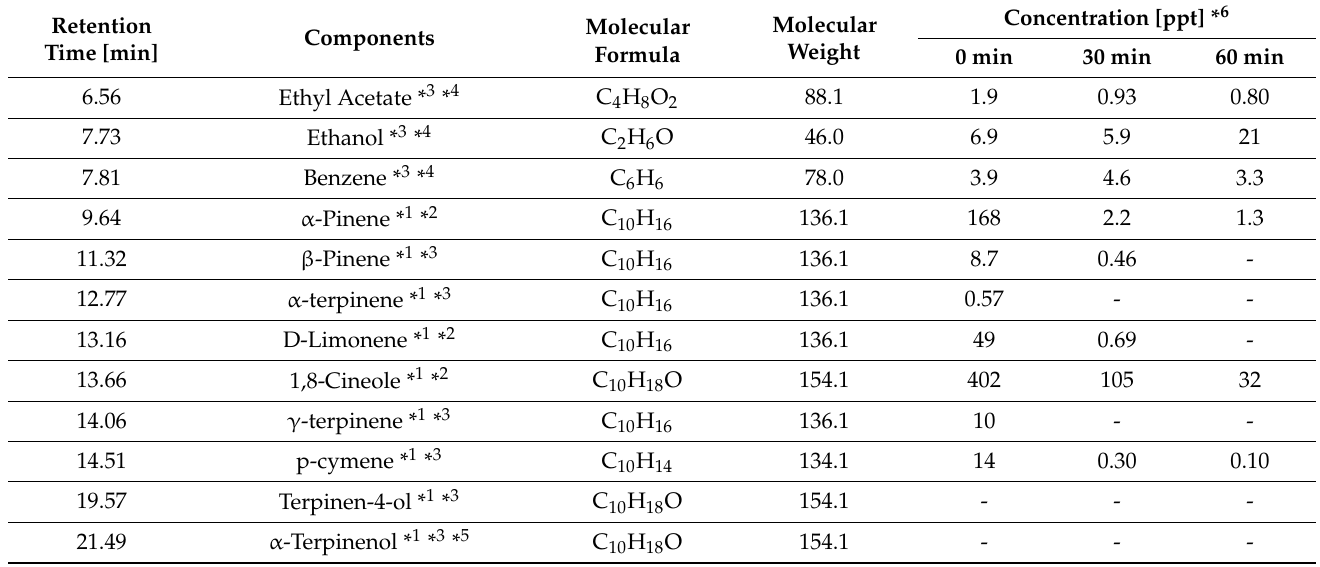
Table 5. The concentration of each component from room air including diffused Eucalyptus